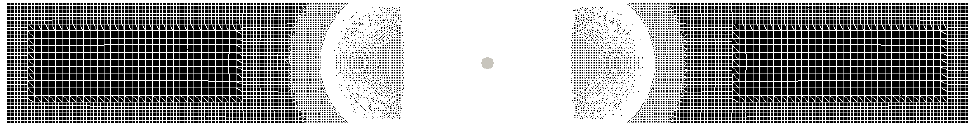
Figure 5. Example of a mesh generated by SnappyHexMesh , which was used for the simulative parameter studies of the influence of the particle shape on the overall pressure drop. To achieve reliable data, the refinement differs depending on the relative location of the particle and the channel walls. In this case, the film thickness between the particle and the channel was 0.